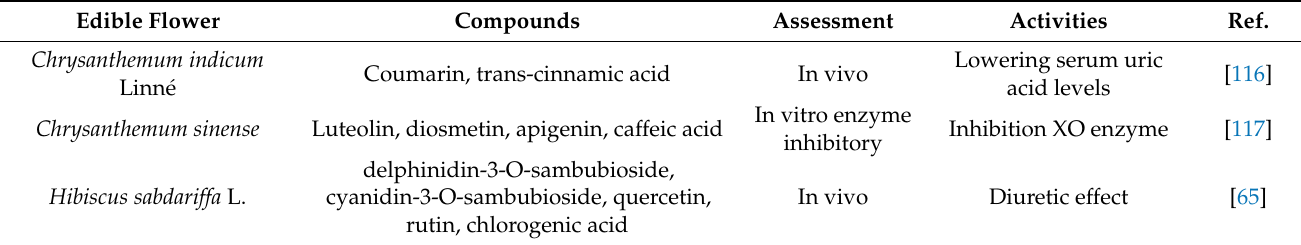
Table 8. Uricosuric activities in edible